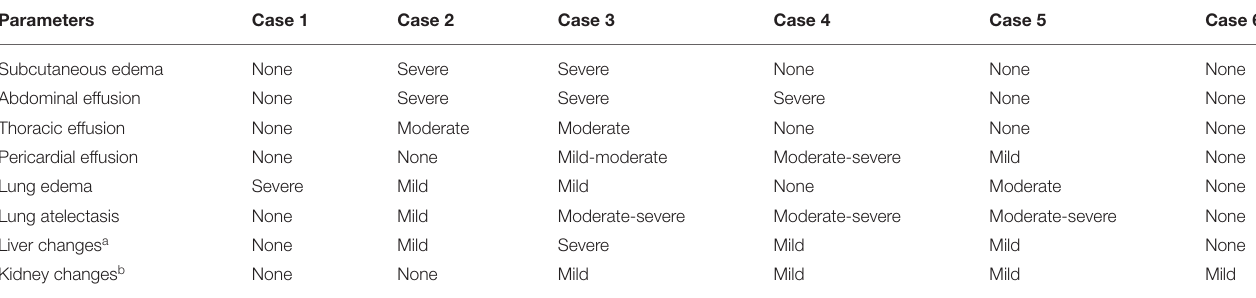
TABLE 5 | Post-mortem findings in other organs than the heart in six Eurasian lynx (subspecies Lynx lynx carpathicus ) from Switzerland affected by cardiomyopathy.